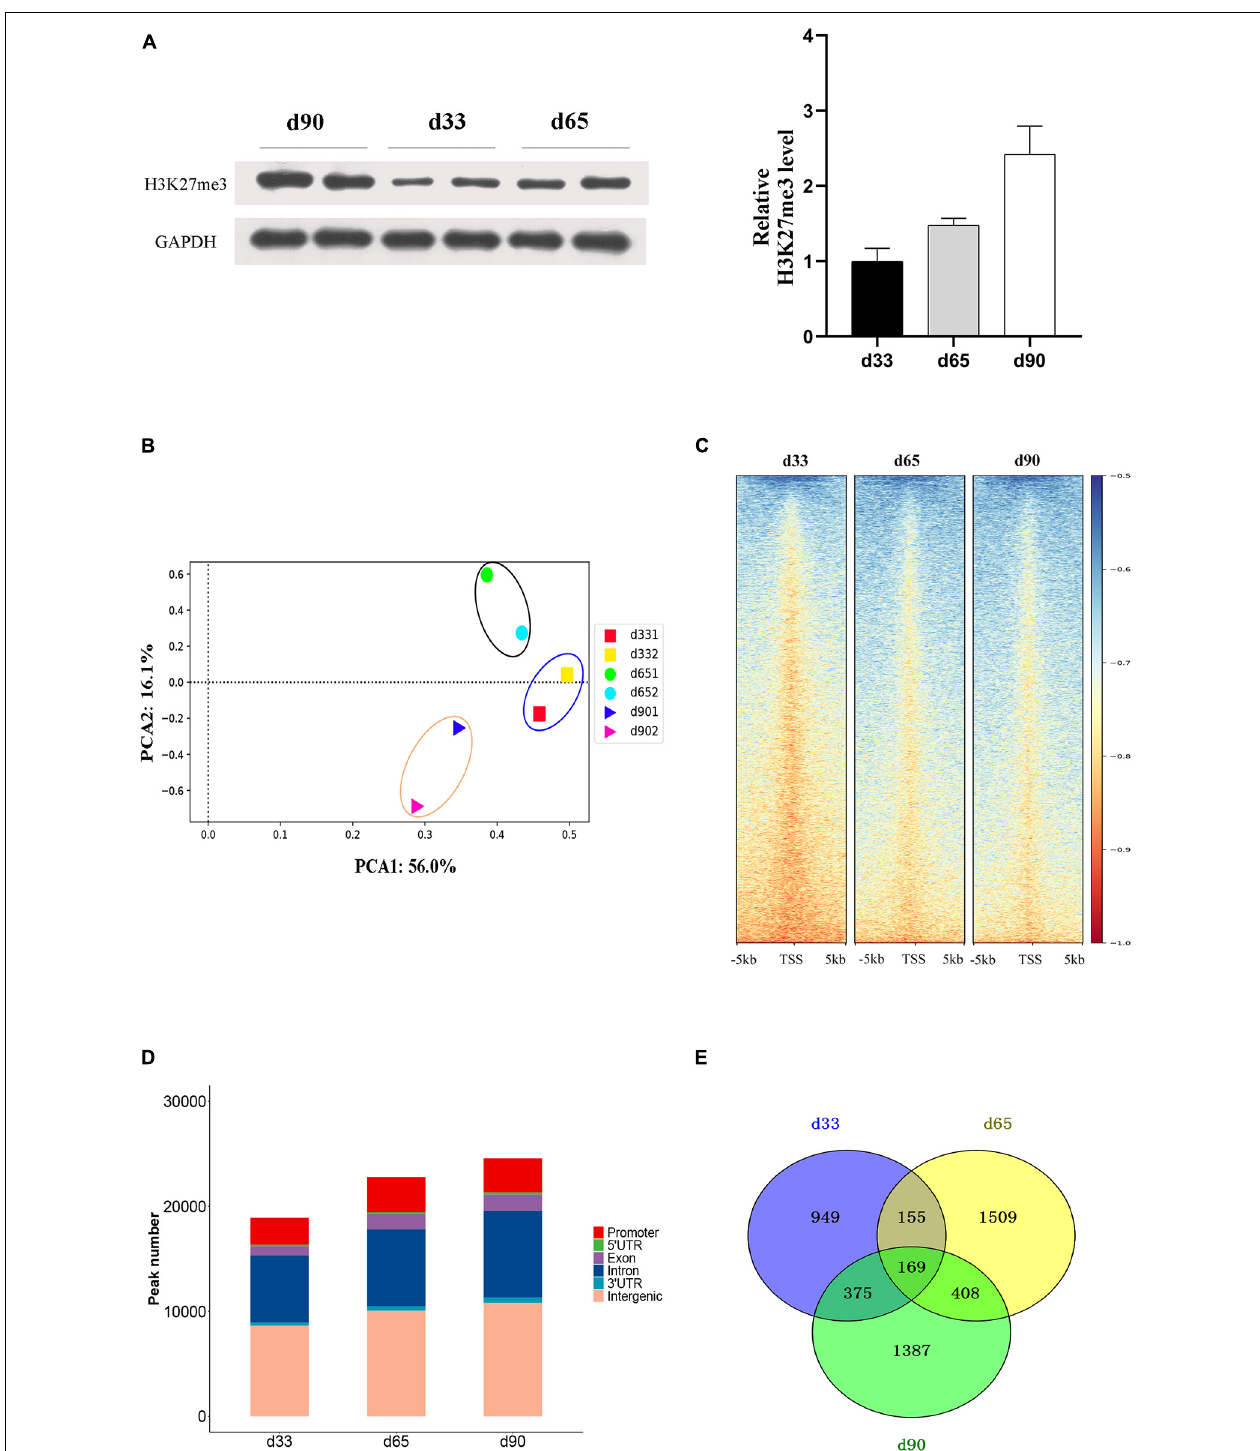
FIGURE 3 | The characteristic of H3K27me3 during embryonic development. (A) Western blotting results showing the dynamics change of H3K27me3 in embryonic muscle development. The protein levels of H3K27me3 were quantified using ImageJ software. (B) Principal component analysis (PCA) of ChIP-seq data of H3K27me3 on d33, d65, and d90. The first and second principal components were depicted as x -axis and y -axis. (C) The enrichment heatmap of H3K27me3 around the 5 kb upstream or downstream of the TSS. (D) The genomic distribution of H3K27me3 region in three stages. (E) Numbers of shared and stage-specific genes associated with H3K27me3 peak in the promoter on d33, d65, and d90.